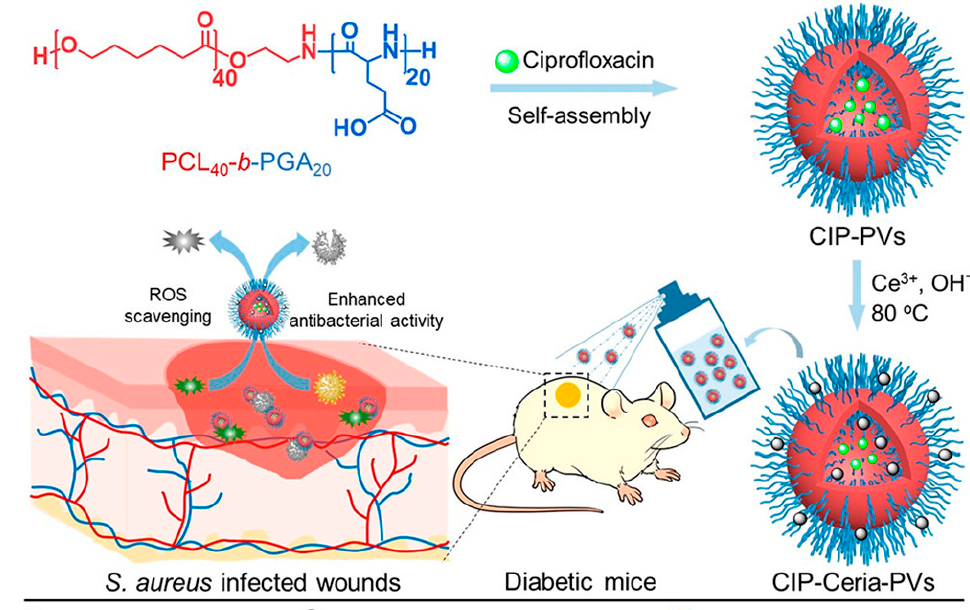
Figure 10. Illustration of the preparation of ciprofloxacin and ceria loaded polymer vesicles and the combined antioxidant–antibiotic treatment of infected diabetic wounds [115] (Reprinted with permission from [115]).